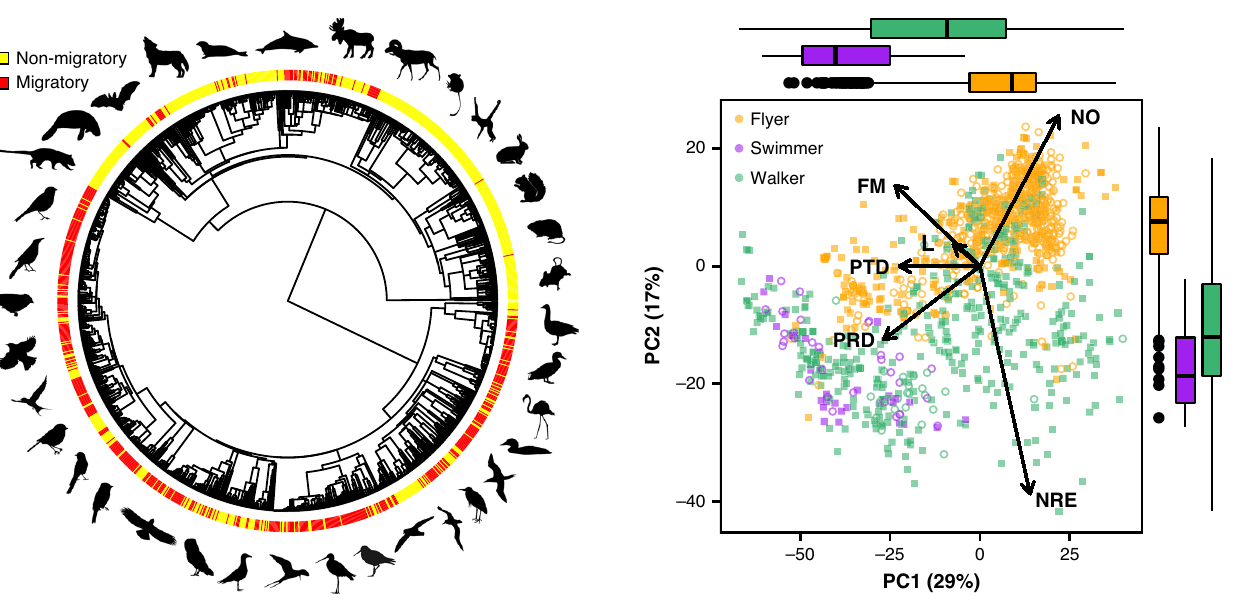
Fig. 1 Phylogenetic tree of mammals and birds. Phylogenetic distribution of migratory species (red) and non-migratory species (yellow). Animal silhouettes were obtained from PhyloPic.